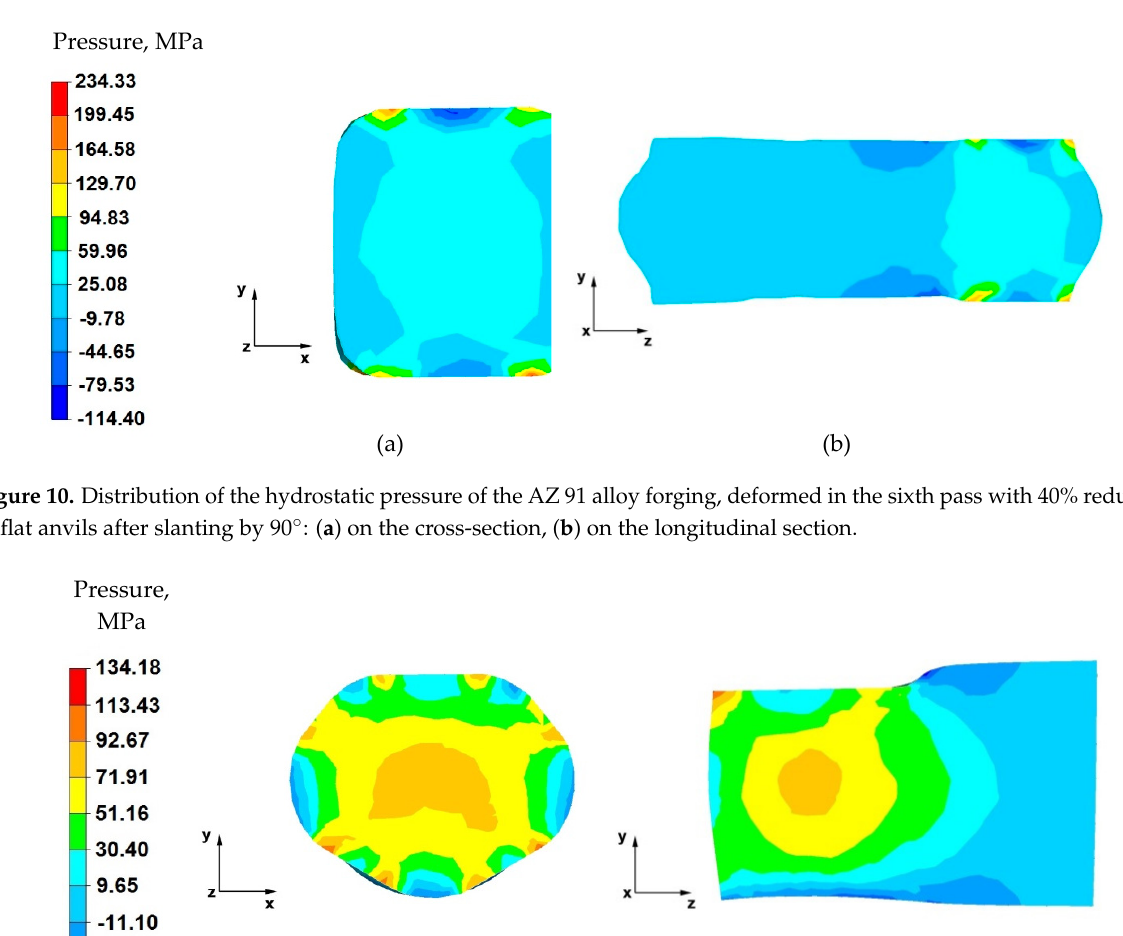
Figure 11. Distribution of the hydrostatic pressure of the AZ 91 alloy forging, deformed in the first pass with 25% reduction in trapezoid and diamond anvils: ( a ) on the cross-section, ( b ) on the longitudinal section.